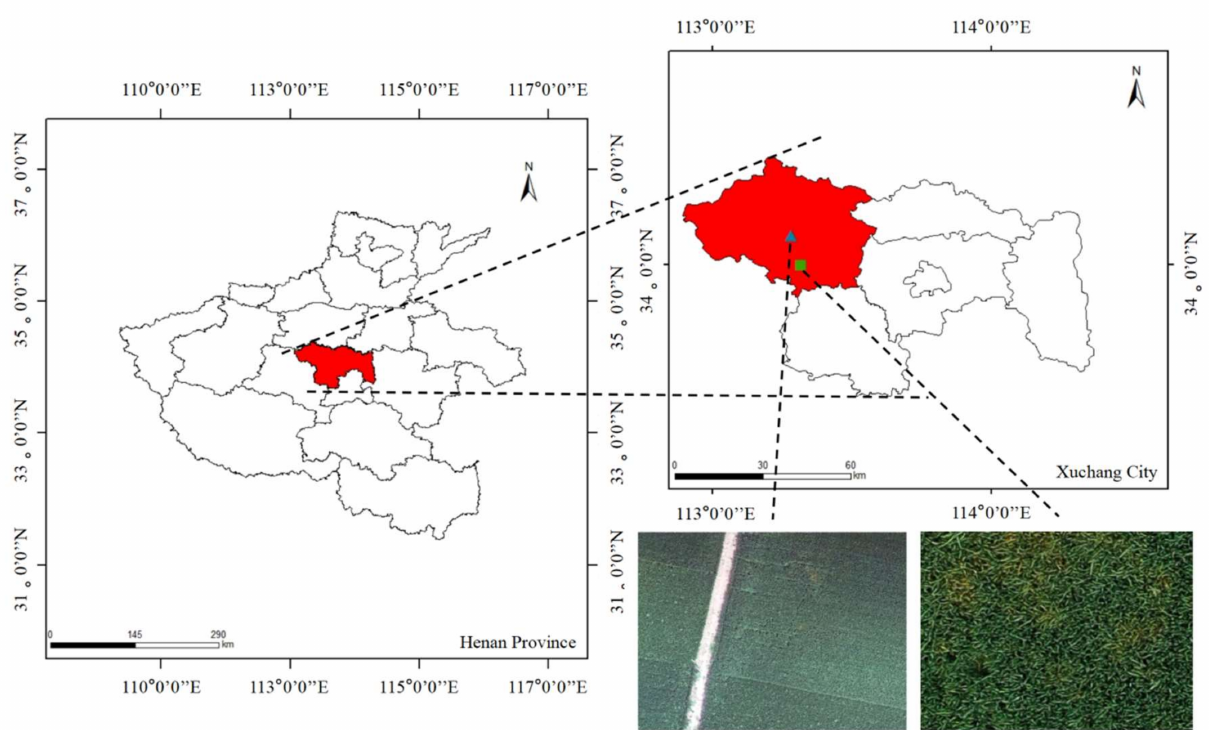
Figure 1. The study area. The left part shows the legend of Henan Province, and the red area indicates Xuchang City. The upper right part shows the legend of Xuchang City; the red area indicates Yuzhou City, the blue triangle indicates the wheat field in Dahuai Village, and the green square indicates the wheat field in Xigolou